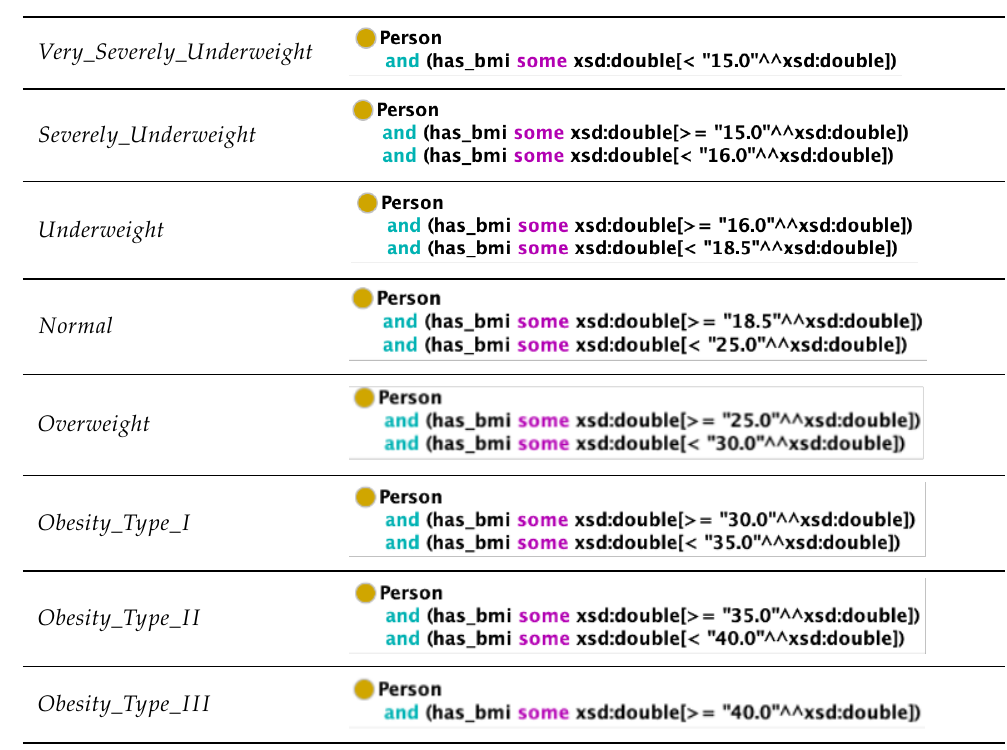
Table 1. Axioms defined in the ontology to specify some nutritional